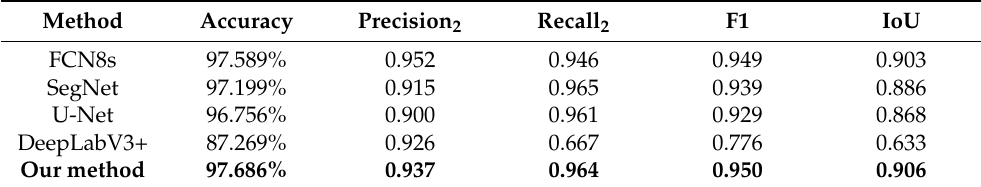
Table 6. The quantitative results of different methods.